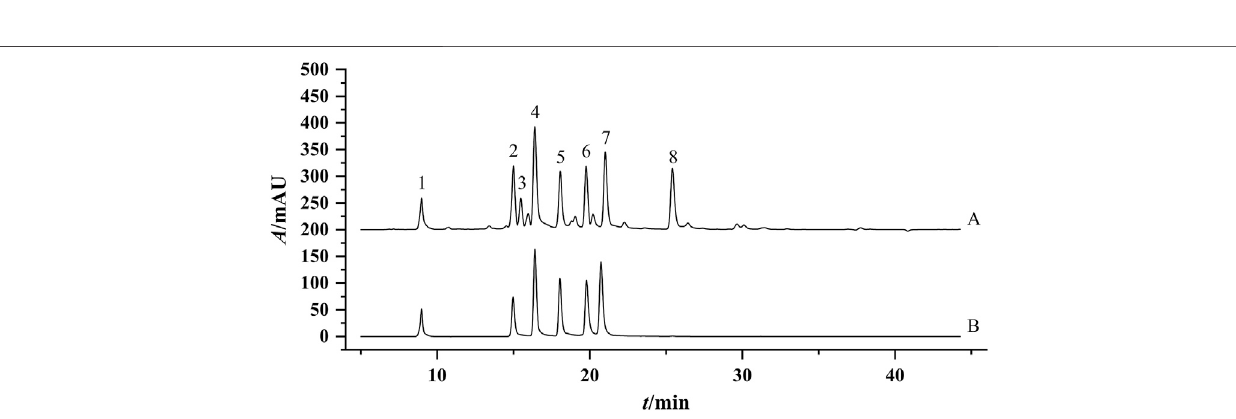
Frontiers in Pharmacology |